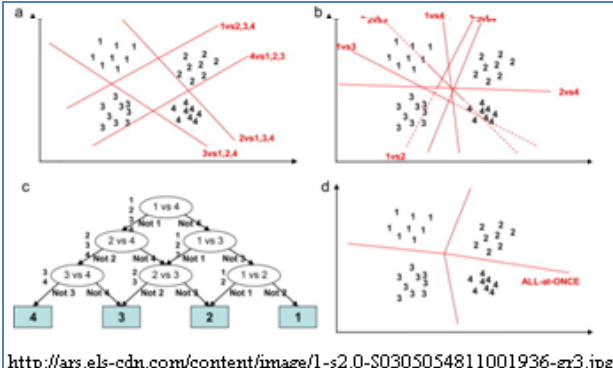
Figure 2. Prototype of general DAGSVM model